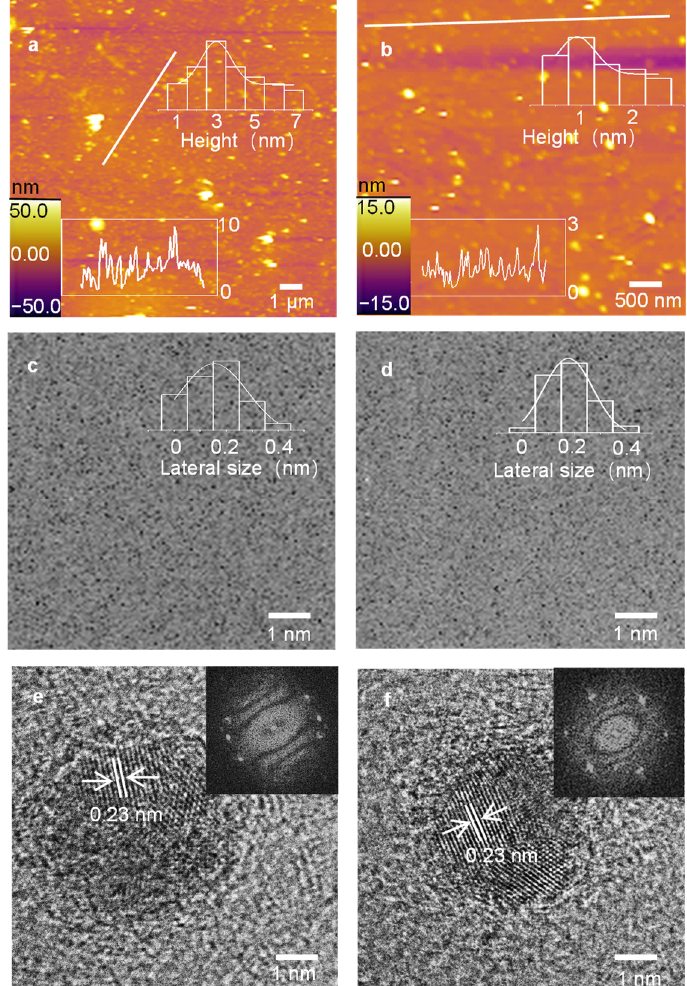
Figure 2. ( a , b ) AFM diagram and height distribution of c-GQDs and o-GQDs. ( c , d ) TEM image and relative size distribution of c-GQDs and o-GQDs. ( e , f ) High resolution TEM images of c-GQDS and o-GQDs (inset: Fast Fourier transform mode).